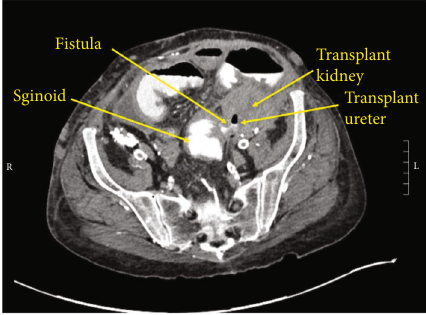
Figure 1: Axial CT of the abdomen and pelvis with rectal contrast demonstrating fi stulous connection between the sigmoid colon and left renal transplant ureter.